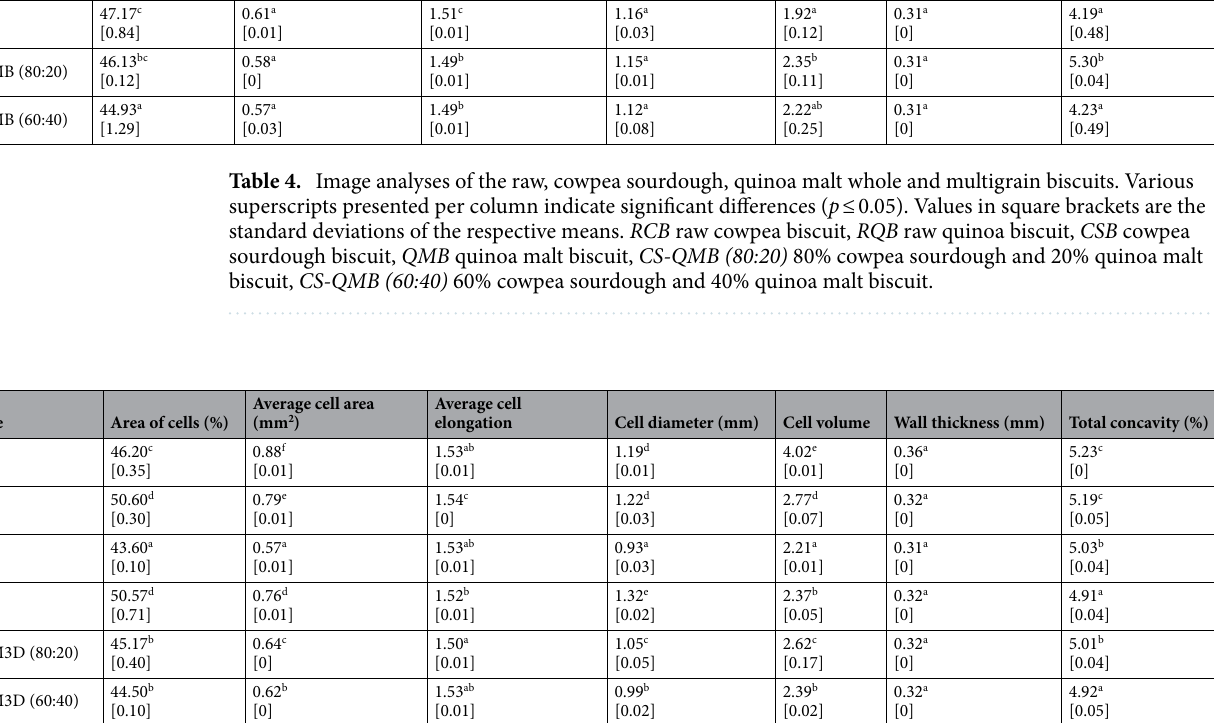
lular and physical characteristics are broadly grouped into cell size (area of cells, average cell area, cell diameter, cell volume, and wall thickness), cell elongation (average cell elongation), and the biscuit shape (total concavity). The cell size and elongation describe the cell information in terms of cell area, average cell elongation, cell diam- eter, cell volume, and wall thickness within the crumb. The biscuits shape is represented as the total concavity extent of the biscuits. The traditionally prepared cowpea sourdough, quinoa malt, and multigrain snacks showed nonsignificant differences (p ≤ 0.05) for the cell size data except for slight differences (p ≤ 0.05) in the area of cells and cell vol- ume. The cell size [area of cells (44.93–47.17%), average cell area (0.57–0.61 mm 2 ), cell diameter (1.12–1.16 mm),